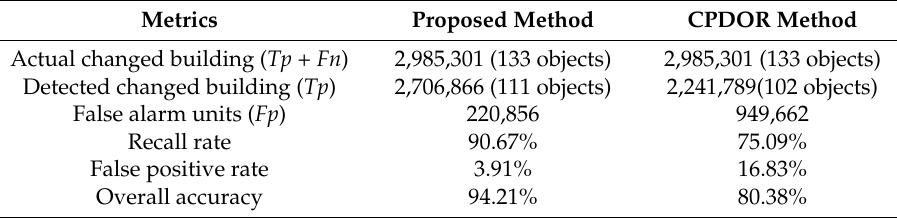
Table 3. Statistical accuracy comparison at the pixel level between the results produced by two